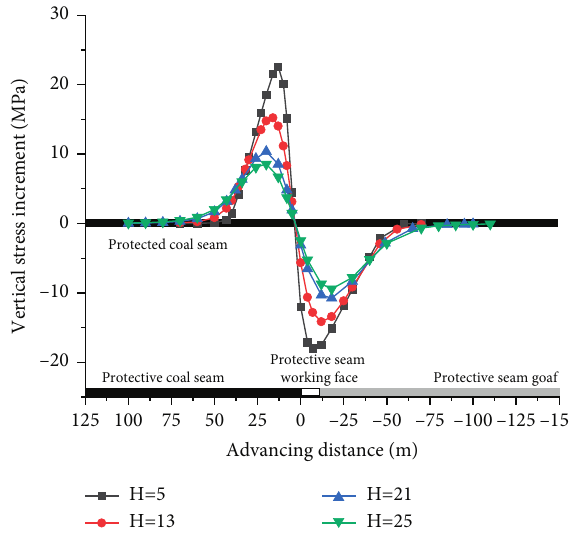
Figure 10: Stress variation curve diagram of different buried depths.